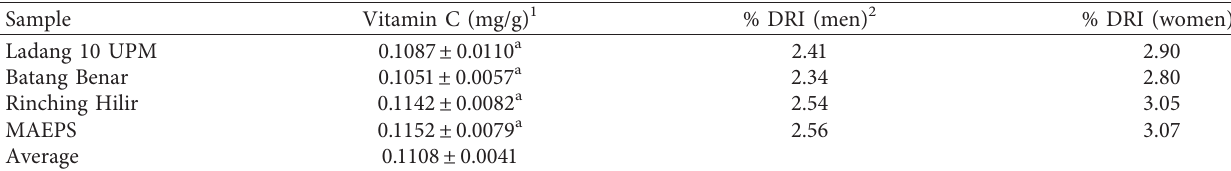
Table 6: Vitamin C content in H. itama bee bread.